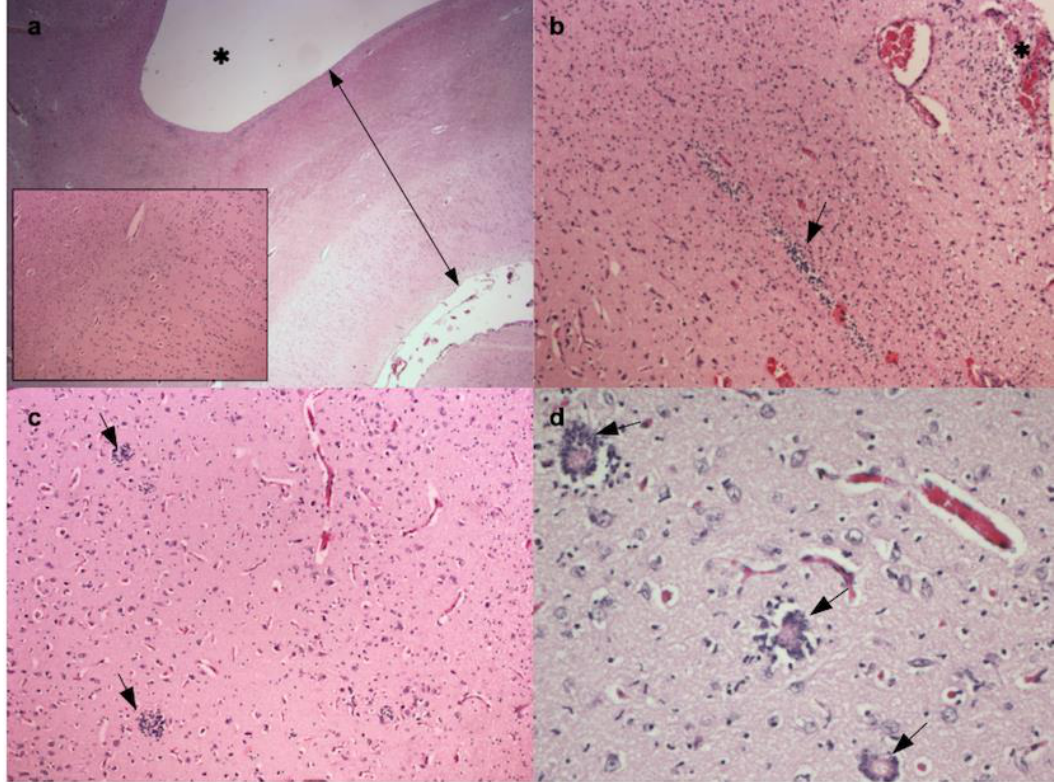
Figure 2. Histopathology. ( a ) Brain. Cerebral parenchyma reduced to a thin layer of white and grey matter covered by meninges (black line) and surrounding a voluminous dilated ventricle (*). The inset shows the maintained histological organization. Hematoxylin and eosin (H&E), 20×. ( b ) Brain. Cerebral parenchyma with multifocal hemorrhages, especially in the periventricular area (*), and multifocal small clusters of stem cells (black arrow) in subventricular zone. H&E, 100× ( c ) Brain. Cerebral parenchyma with multifocal clusters of undifferentiated cells into the gray matter (black arrows). H&E, 100× ( d ) Brain. Diencephalon with multifocal small rudimental ventricles (black arrows). H&E, 200×.